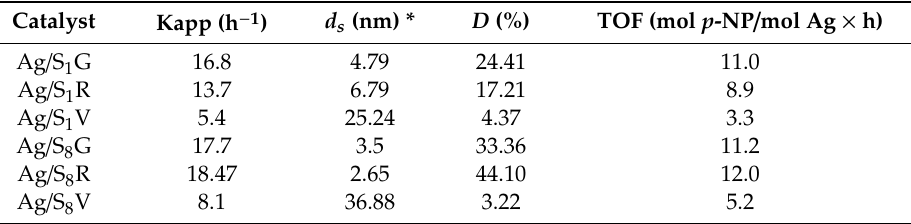
Table 1. Metal particle size ( d s ), dispersion ( D ), apparent rate constant ( K app ) and turnover frequency (TOF) for the studied